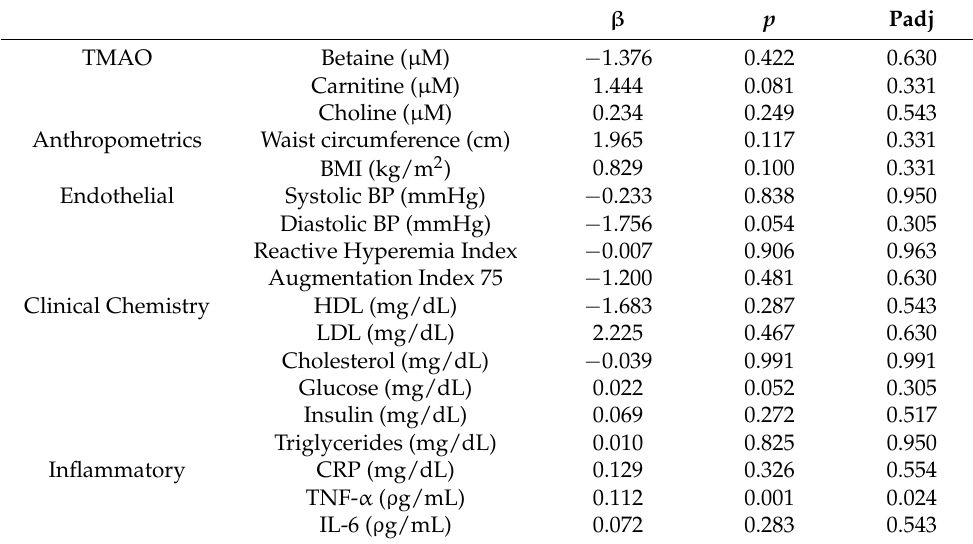
Table 3. Relationships between cardiometabolic risk factors and fasting plasma TMAO.